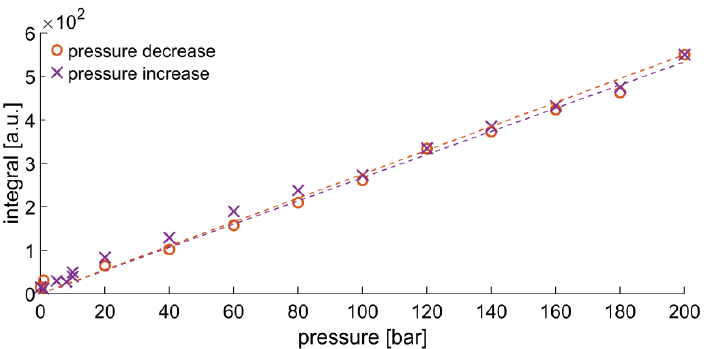
Figure 2. Peak integral of H 2 dissolved in d -methanol between 1 and 200 bar. Only the right half of the H 2 peak was integrated to reduce the influence of the overlapping OH peak from residual non-deuterated methanol. The dotted lines are linear fits of H 2 peak integrals obtained when raising the pressure from 0 to 200 bar (purple) or lowering it from 200 to 1 bar